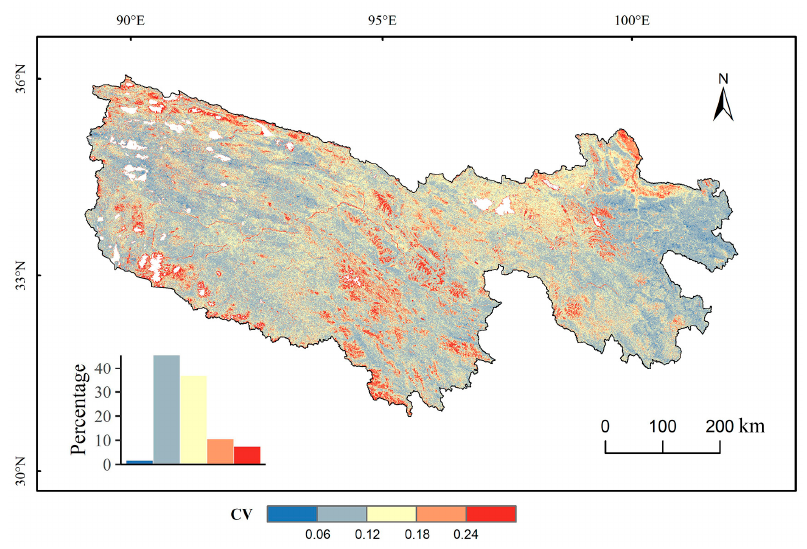
Figure 5. Spatial distribution of CV in the TRHR during 2000–2021.